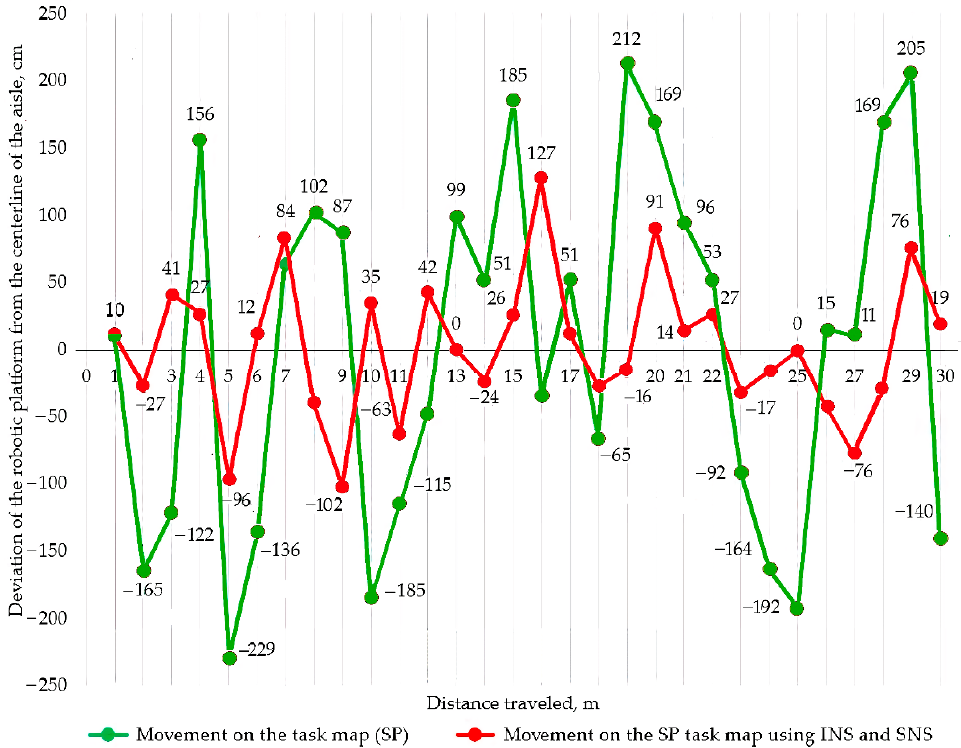
Figure 18. A fragment of the graph of the dependence of the traveled path on the deviation of the robotic platform from the centerline of the aisle.